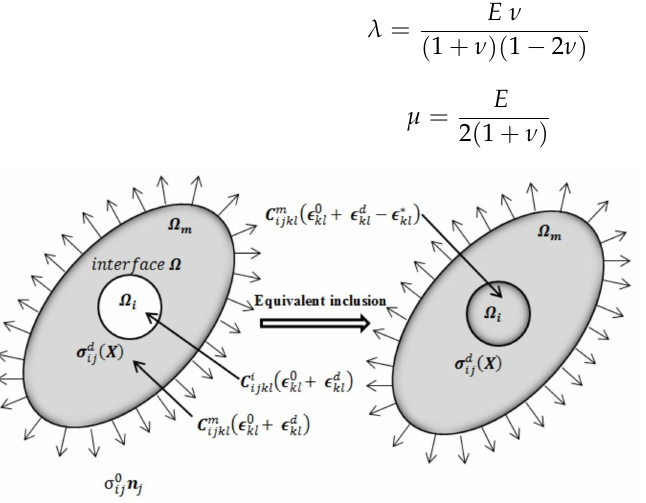
Figure 2. Eshelby’s equivalent inclusion